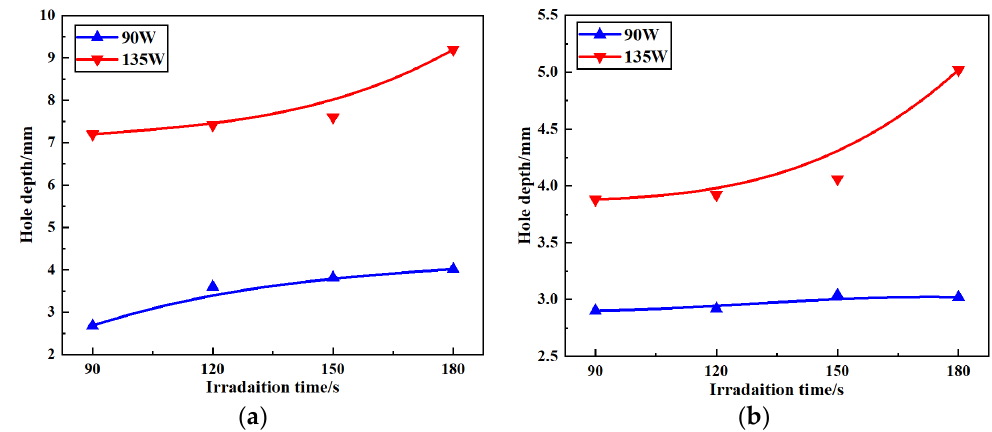
Figure 6. Variation of hole depth with irradiation time under different conditions ( a ) dried sample; ( b ) soaked sample.